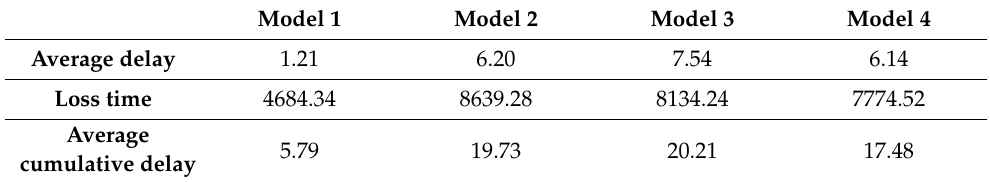
Table 8. Experimental results of the four models in the same traffic scenario as during training.